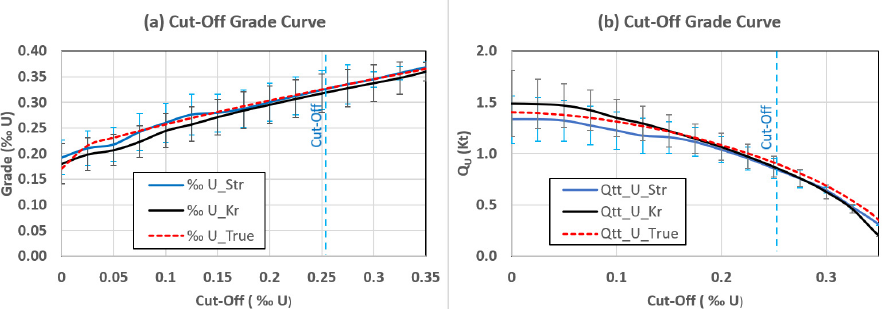
Figure 16. Grade cut-off diagrams with resources (blue) and grades (orange) over cut-offs ranging from 0 to 0.35 ‰U, together with fitted trend lines (dotted) and exploitation cut-off at 0.3‰U (blue vertical dashed line) for ( a ) streamline-based proposed method; ( b ) kriging method; ( c ) true resources taken from the simulated deposit.